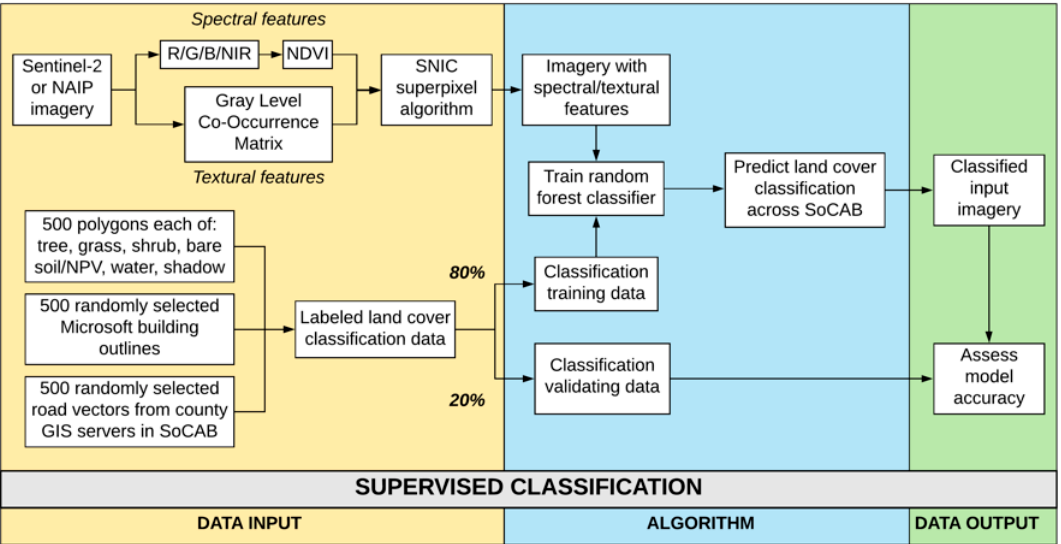
Figure 2. Our workflow for supervised classification of urban vegetation can be implemented with multispectral Sentinel-2 or NAIP imagery using labeled training polygons from across SoCAB. This method utilizes both spectral and textural features. The classification accuracy is determined from presence-only validation data separated from the training data prior to training the random forest classifier in Google Earth Engine.